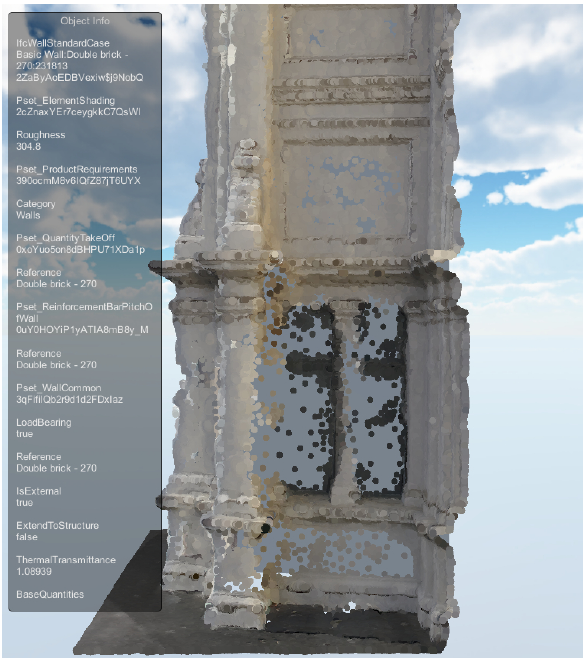
Figure 3. The point cloud of a wall building element after the point cloud cutting function is performed. Only the left-hand side of the split-screen is shown.